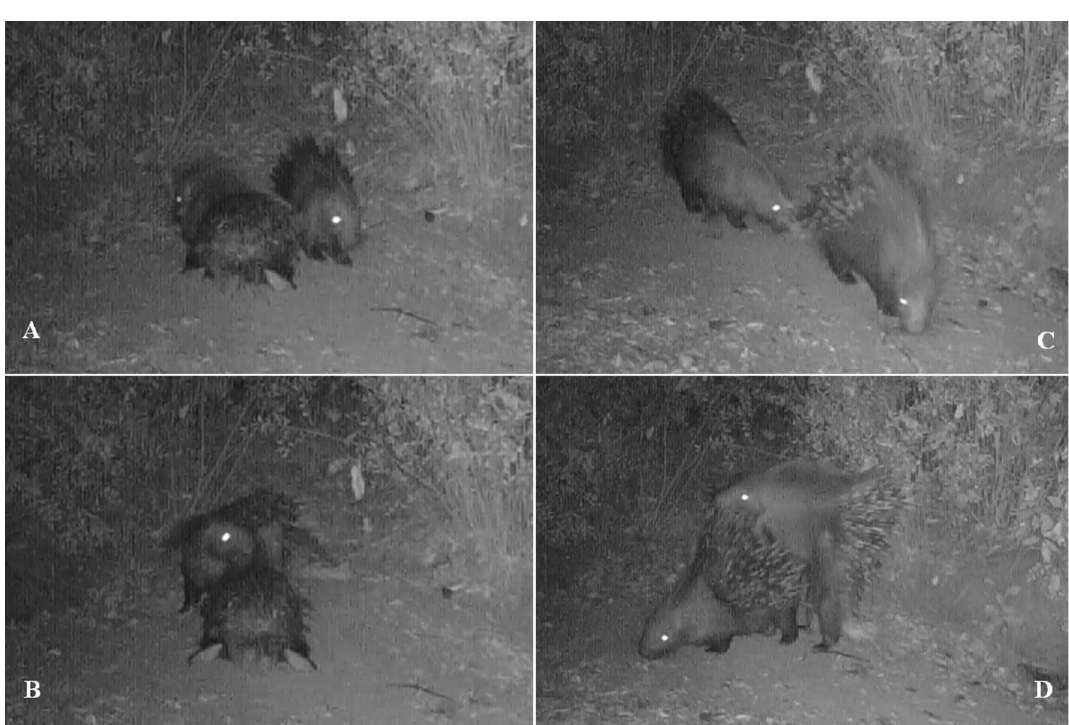
Figure 3. Mounting behavioural sequence observed in Pair 7: ( A ) resting behaviour, ( B ) Mutual-allo-grooming behaviour, ( C ) following associated with Nose-quills contact behaviour ( D ) and mounting